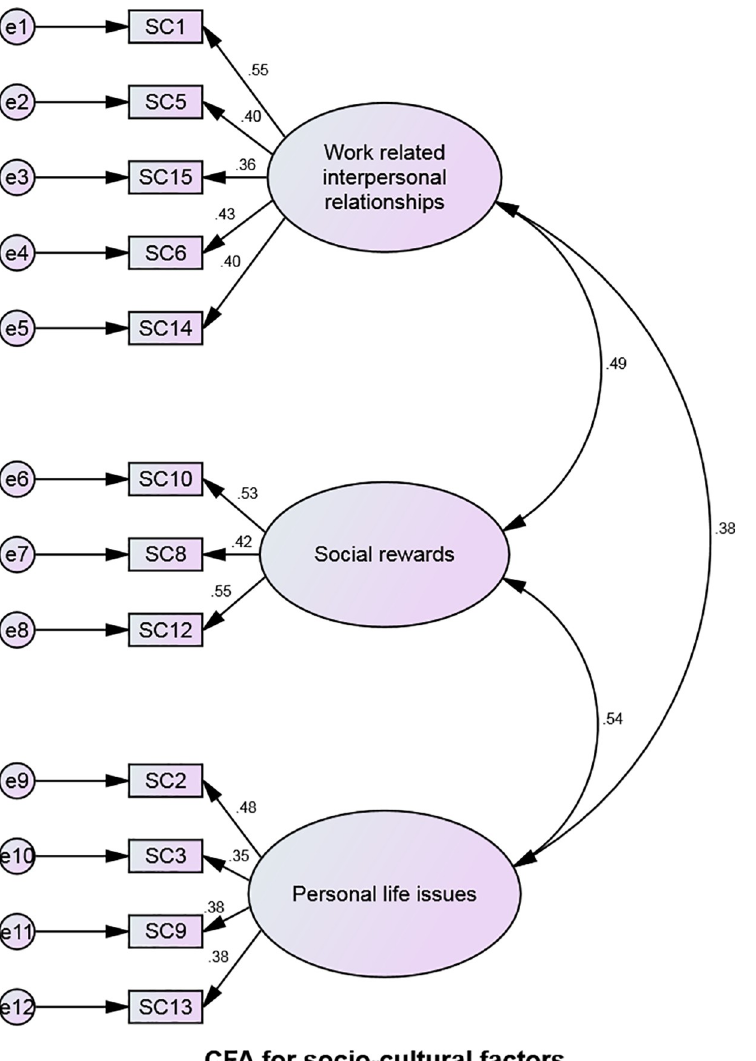
Fig 4. Confirmatory Factor Analysis (CFA) for socio-cultural factors.